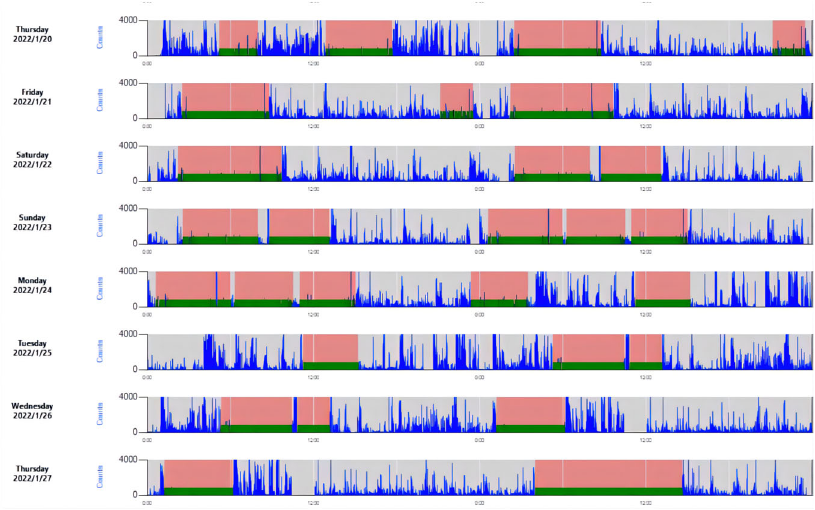
Figure 3. Sleep analysis example using ActiLife 6.13.4. The translucent red denotes sleep period, the green denotes sleep score indicator, and blue denotes activity counts.